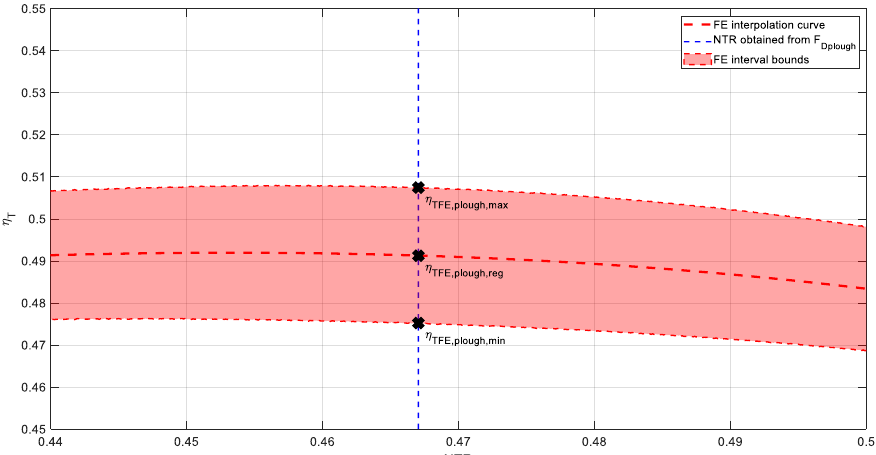
Figure 5. Example of traction efficiency estimation for tractor configuration FE and 8th gear. η T FE,reg is the estimation based on the regression model; η T FE, min is based on the lower prediction bound and η T FE, maxg is based on the upper prediction bound for the model.